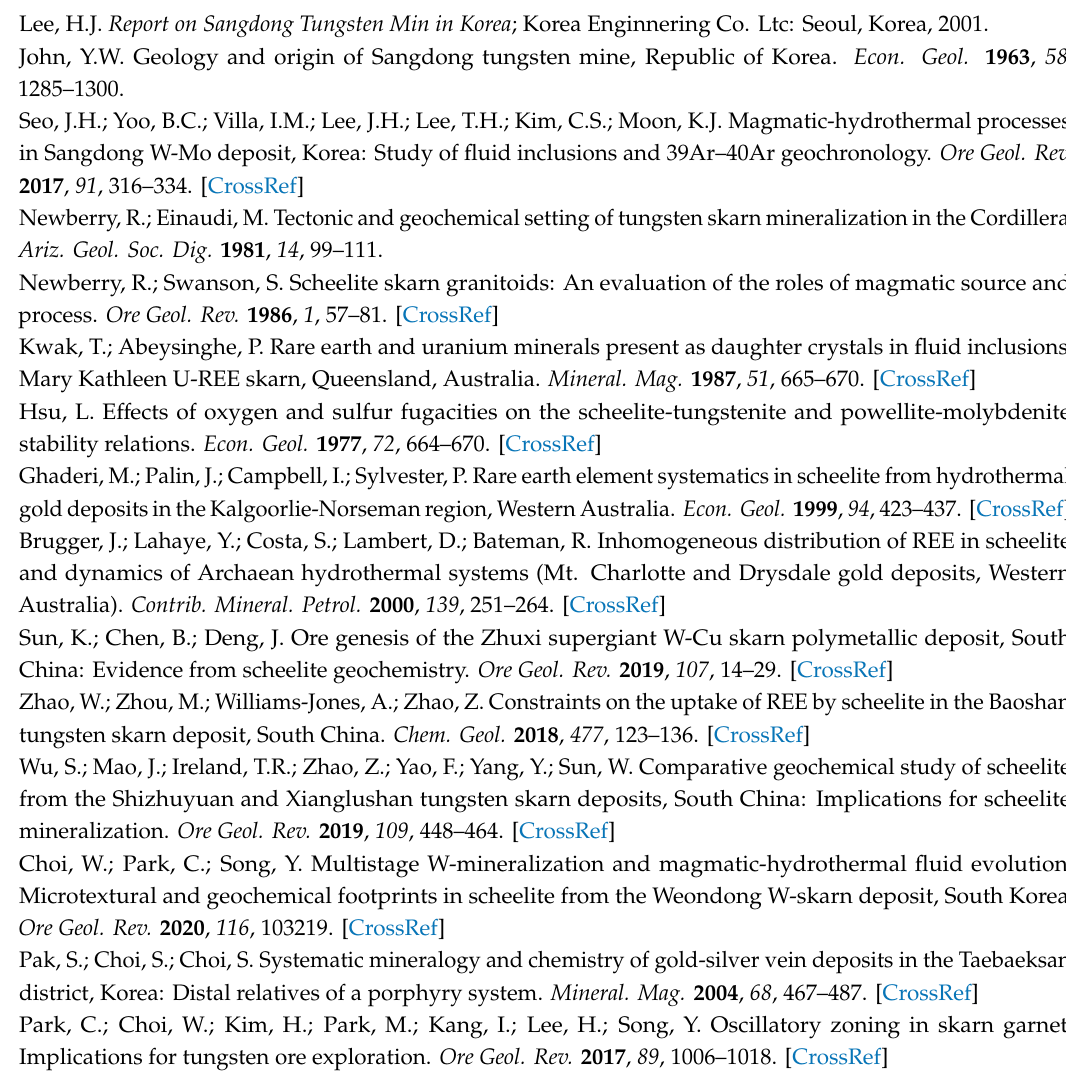
Table S1: Raw data of scheelite EPMA analysis, Table S2: Raw data of scheelite LA-ICP-MS analysis, Table S3: Chlorite geothermometry